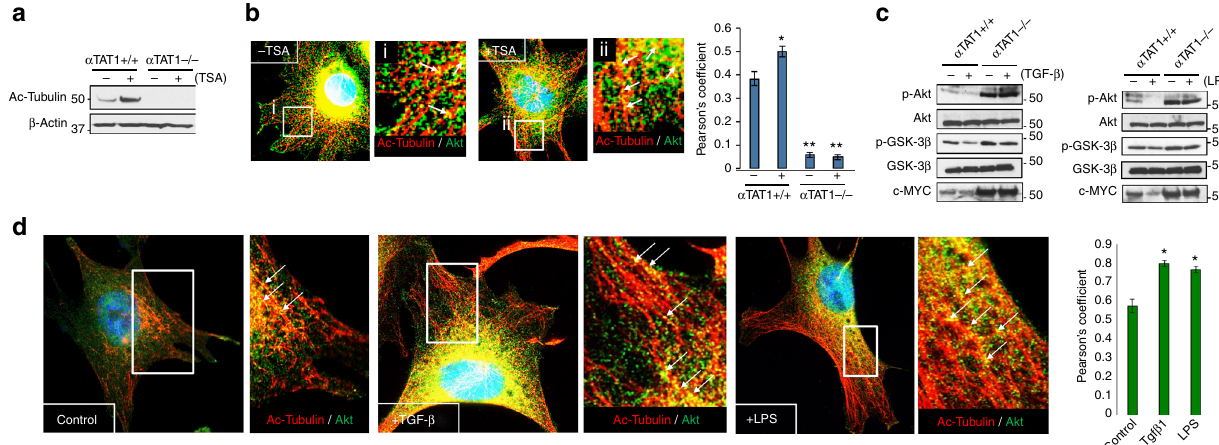
Fig. 6 MT acetylation inhibits AKT activation. a Western blot analyses demonstrating acetyl tubulin level post Trichostatin A (TSA; 500 nM) treatment for 30 min in α TAT1 + / + and α TAT1 – / – MEFs. b α TAT1 + / + and α TAT1 – / – MEFs were treated with 500 nM of TSA for 30 min before fi xing and immuno fl uorescence staining for acetyl tubulin (red) and total Akt (green). Representative images are obtained from α TAT1 + / + MEFs with and without TSA treatment. Acetyl tubulin levels were undetectable in α TAT1 – / – cells. Pearson ’ s correlation coef fi cient was calculated to determine the proximity between acetyl tubulin and total Akt. Image J plugin called Just another co-localization plugin (JACoP) was used to quantify the images. Thirty cells per condition and three ROIs per cell were quanti fi ed. Error bars represent SEM and type 2 t -test analysis show relative to α TAT1 + / + control: * p < 0.05, ** p < 0.0001. c α TAT1 + / + and α TAT1 – / – MEFs were treated with TGF- β 1 (200 pM; 30 min) or LPS (10 ng/ml; 30 min) before western blot analyses of the lysates for levels of pAKT S473, total AKT, pGSK3 β , total GSK3 β , and c-MYC. d Immuno fl uorescence images demonstrating localization of acetyl tubulin (red) and total Akt (green) in α TAT1 + / + MEFs post treatment with TGF- β 1 (200 pM; 30 min) or LPS (10 ng/ml; 30 min). Pearson ’ s correlation coef fi cient was calculated using JACoP, 15 cells per condition, and 3 ROIs per cell were quanti fi ed. Error bars represent SEM and type 2 t -test analysis show relative to α TAT1 + / + control: * p <